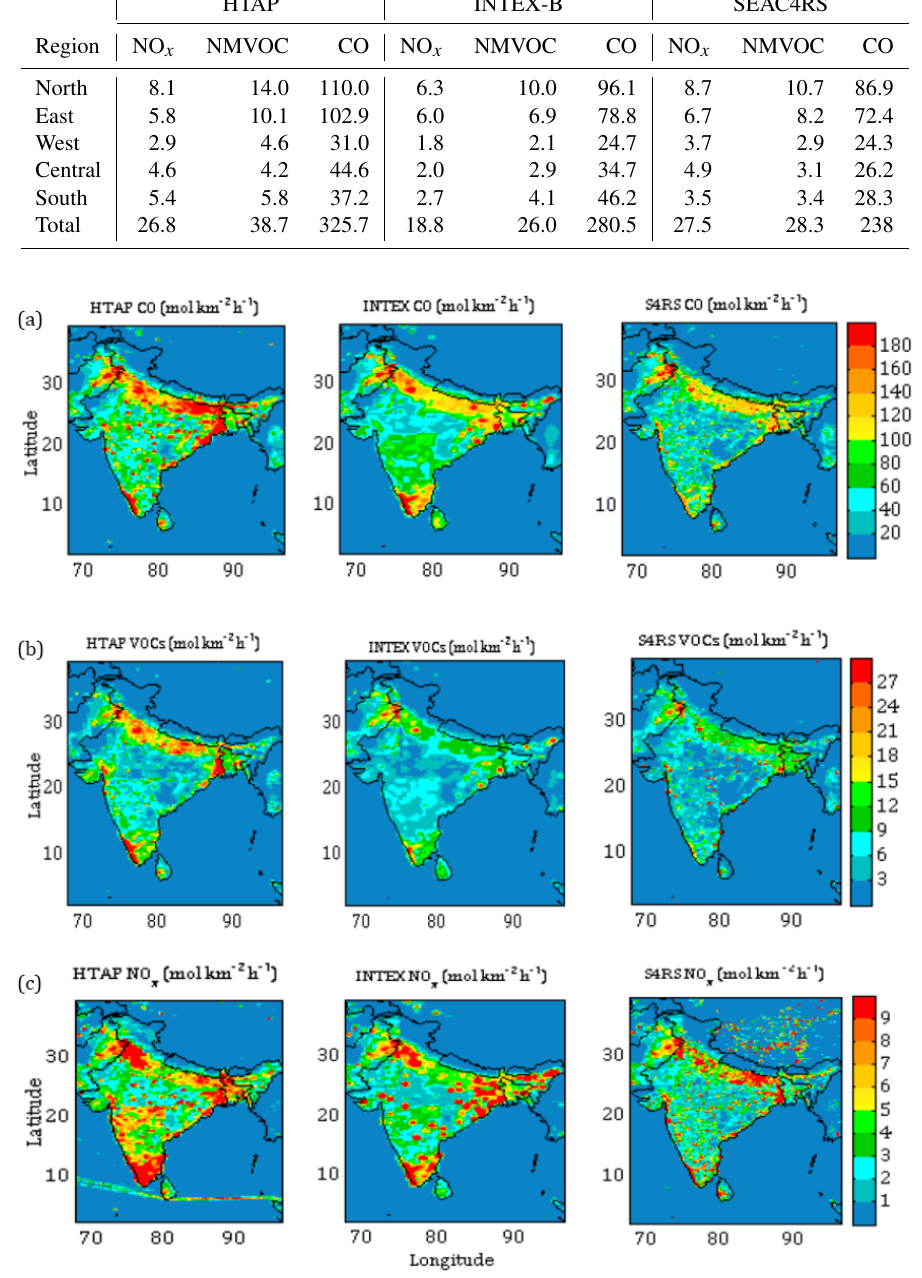
Figure 2. Comparison of (a) CO, (b) NMVOC and (c) NO x emissions between the three inventories used (see Sect. 2.2 for